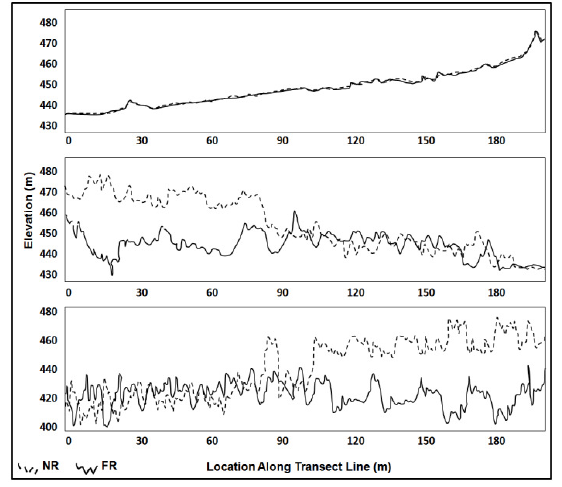
Figure 6. Three examples of X-HH airborne flight line twisting. The top graph illustrates a strong correlation between the NR (dashed line) and FR (solid line) for two flight line strips (that have been controlled using ground control) over the same transect line. The middle and bottom graphs for a transect line located both in the NR and FR do not correlate well. In the middle graph, the beginning of the transect (left side of the graph, starting at number 1 does not compare well in NR and FR, but they begin to converge at about data point #81 approximately 54 km from the start of data collection for the NR pass and at 104 km for the FR pass. The bottom graph shows a strong correlation between NR and FR profiles along the same transect line at the beginning, but they begin to separate from each other at about data point #169 approximately, 68 km from the start of data collection for the NR line (pass #1) and at 134 km for the blue line (pass